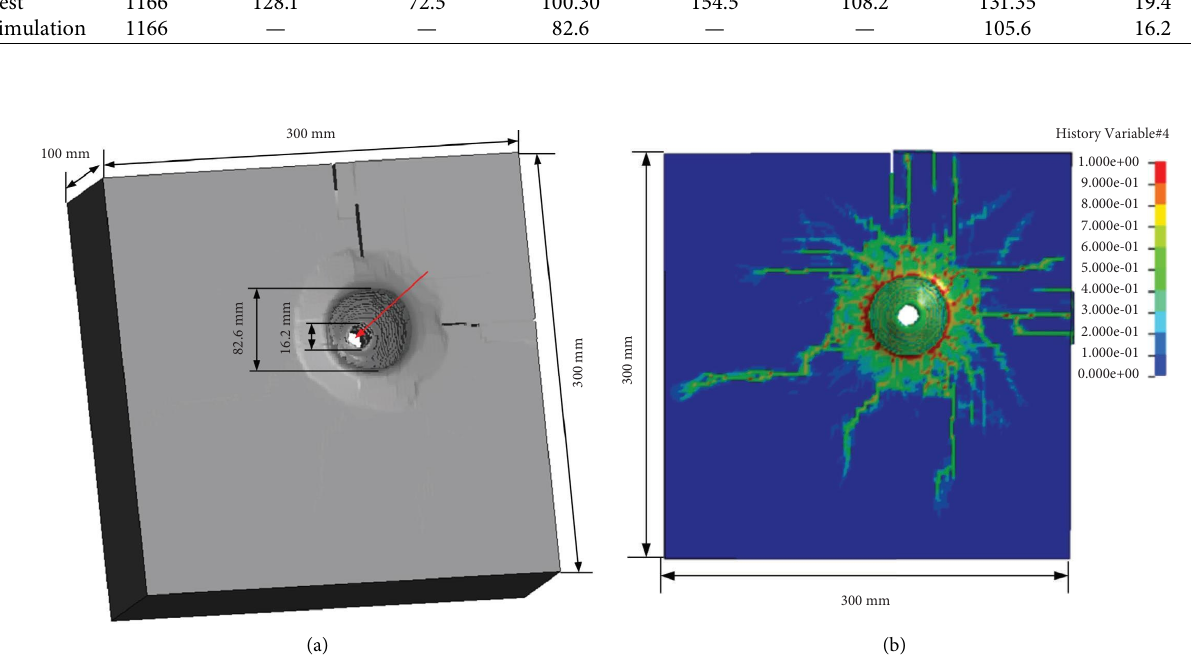
Figure 7: Simulation results of a fragment velocity of